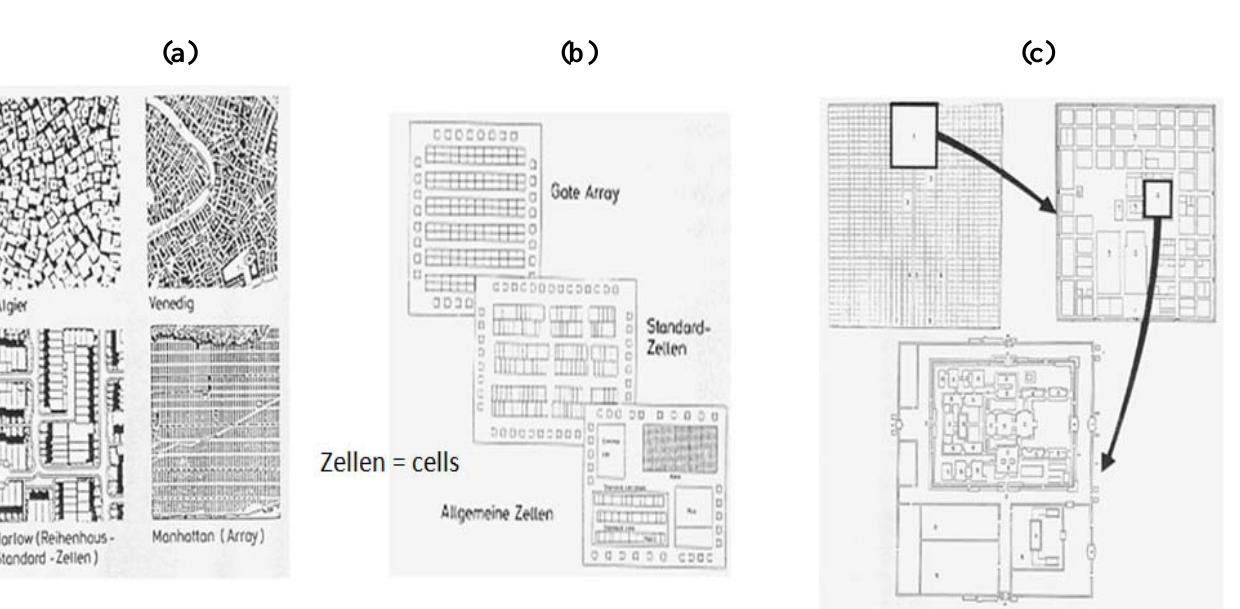
Figure 2. Similarities between the architecture of integrated circuits (( a ) different kinds of city architecture; ( b ) architectures of integrated circuits; ( c ) the king’s palace in a city in Japan) and the cultural environment of the engineer (picture from Rüchardt [32], with kind